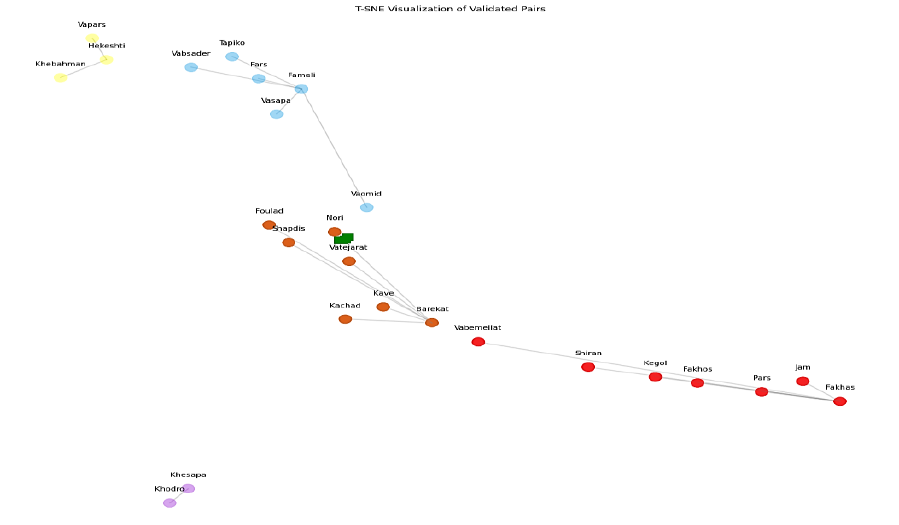
Figure 13. Clustering by the t-SNE